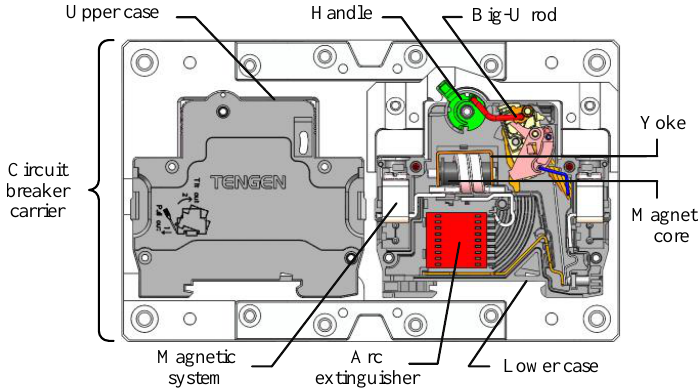
Figure 1. Internal structure of an MCB.